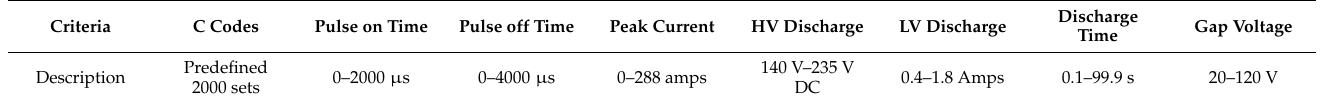
Table 4. Parameters and results of the experiments on ZTA at 80 V.